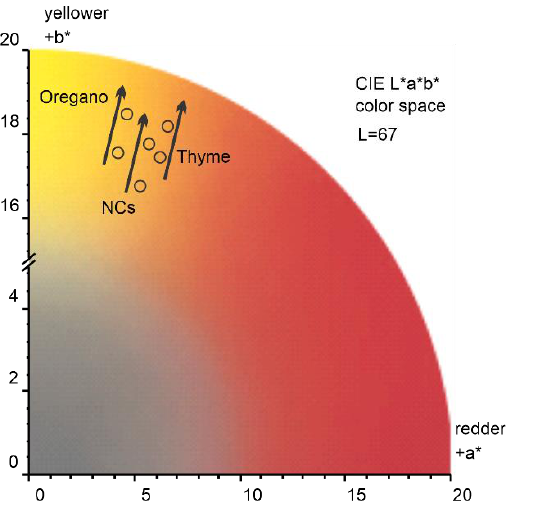
Figure 4. Sandstone color changes after the application of Or-NCs, Th-NCs, and NCs, encoded in CIE L*a*b* color space.